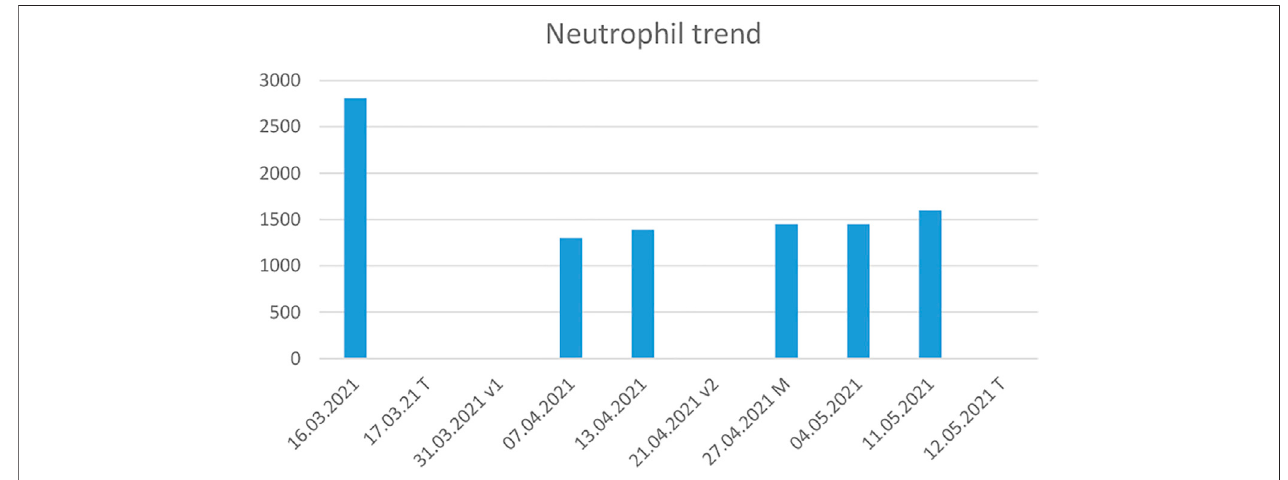
FIGURE 2 | Graphical representation of the neutrophil trend, which declined after the fi rst vaccine dose and whose persistently a low level required extending the interval between antiblastic treatments to nearly 2 months. T: treatment administration, v1: fi rst vaccine dose, v2: second vaccine dose, M: mushrooms integration.